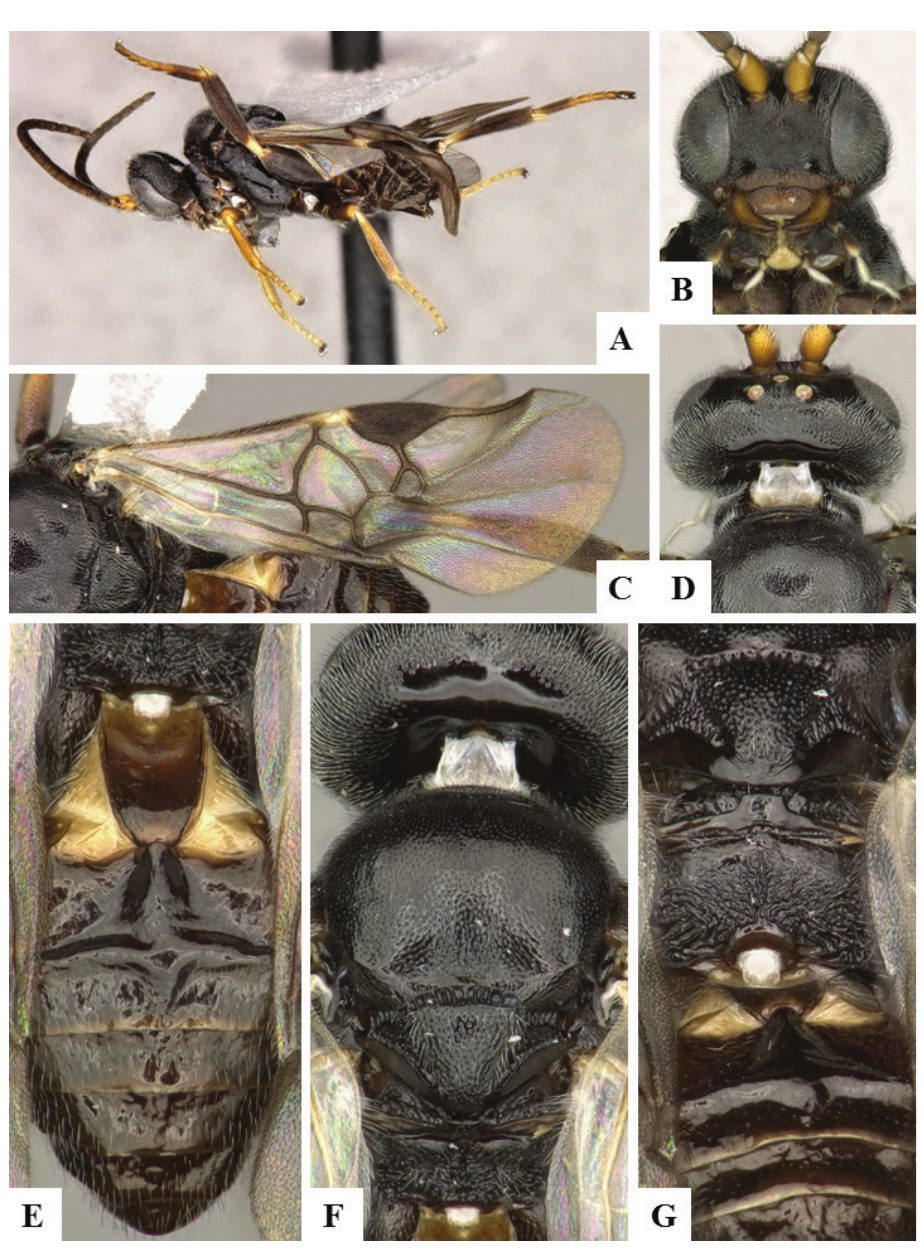
Figure 34. Silvaspinosus vespa female holotype. A Habitus B Head frontal C Fore wing D Head dorsal E Metasoma dorsal F Mesosoma dorsal F Propodeum. from lateral areas by weak sulcus. T3+ smooth and with sparse, relatively long setae. Hy- popygium relatively short, not extending beyond last tergites. Ovipositor sheaths mostly smooth and very short, 0.14 × metatibia length. Body measurements (mm). F2 L: